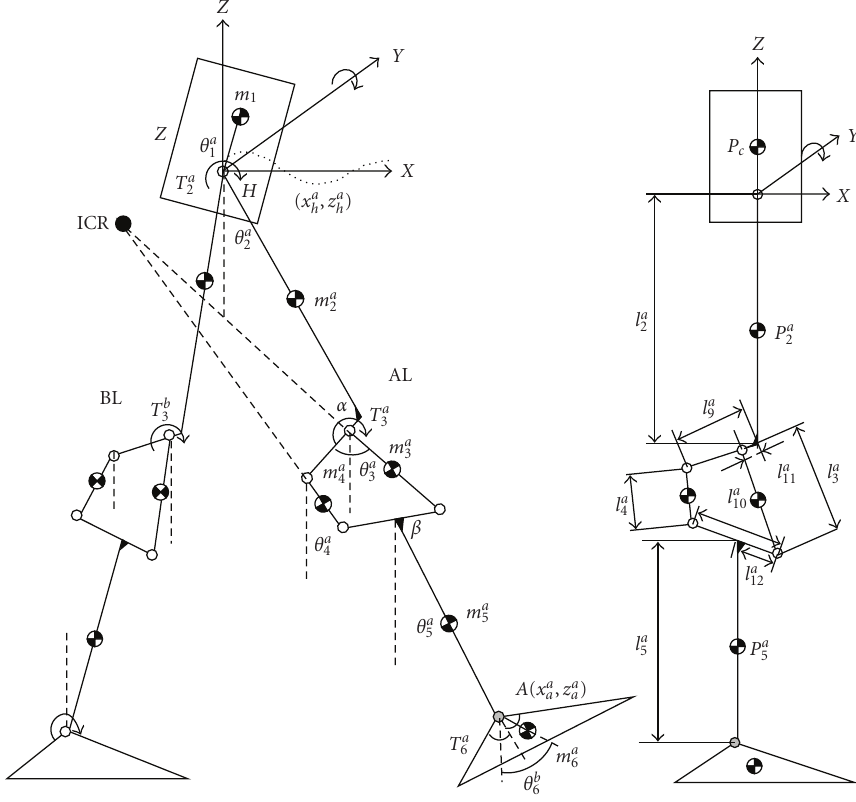
Figure 3: Mass and geometry